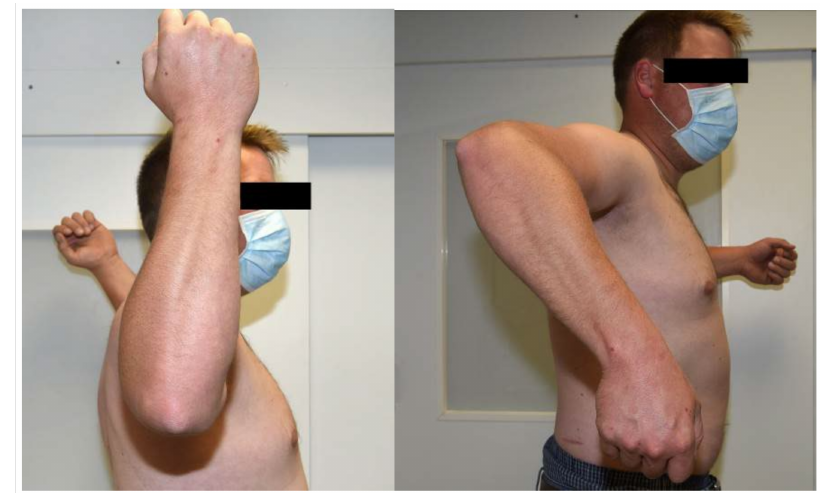
Figure 5. Case study: Active range of rotational motion of the unaffected shoulder.